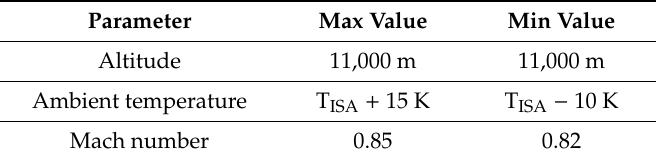
Table 2. Uniform distributions characteristics for flight parameters (Case 2).